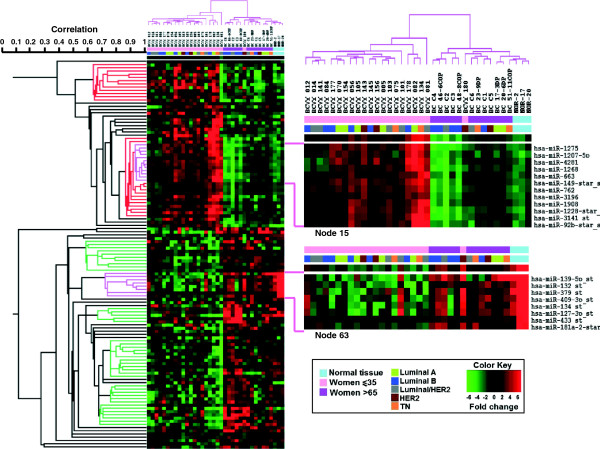
Heatmap representing an unsupervised cluster performed according to a hierarchical clustering method centered on the median, using differently expressed human miRNA expression values from an Affymetrix array assay. The miRNAs plotted are those which gave significant FDR p-values after performing a t-test according to the age group of the samples. Correlation values (0–1) of different sub-nodes are shown in the figure according to data obtained from Cluster and Treeview software. The two most correlated, overexpressed-sub-nodes are highlighted in red (from top to bottom, sub-node 92 and sub-node 29); highlighted in green are the most correlated repressed sub-nodes (from top to bottom 102, 79, 52, 54 and 73). The selected nodes for validation are shown in pink (node 15 and node 63).